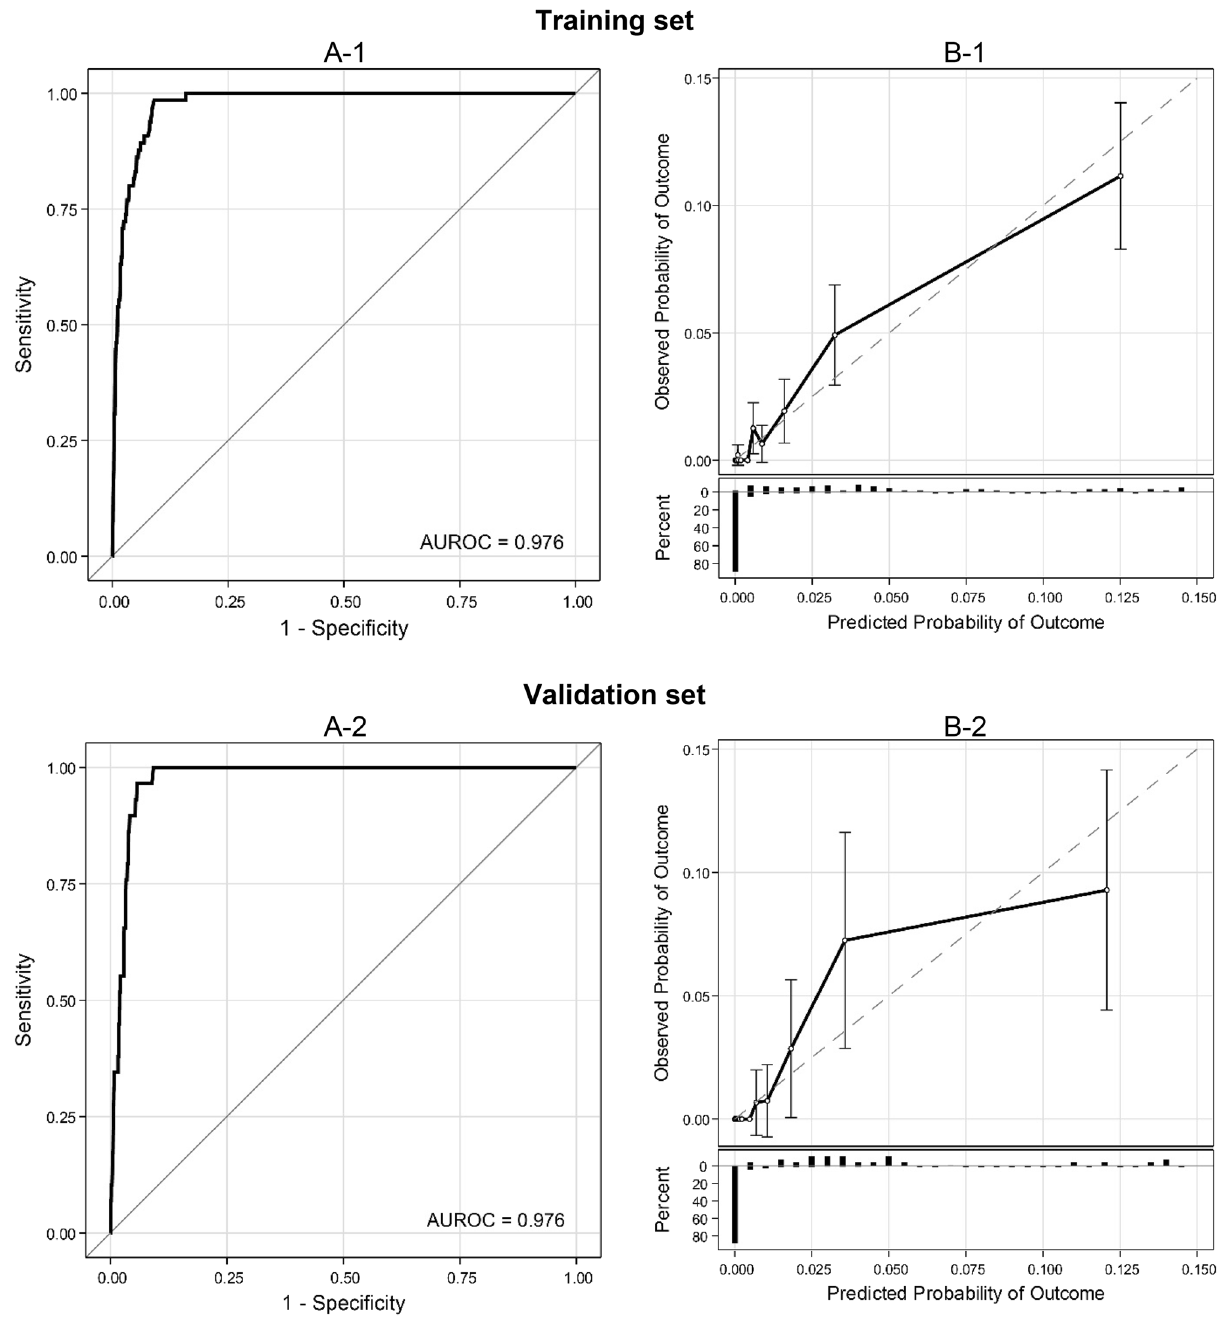
Figure 3. ROC curves ( A ) and calibration plots ( B ). The AUROC [95% CI] for the training and validation sets were 0.976 [0.969, 0.984] and 0.976 [0.968, 0.984], respectively. AUROC area under the ROC, ROC receiver operating